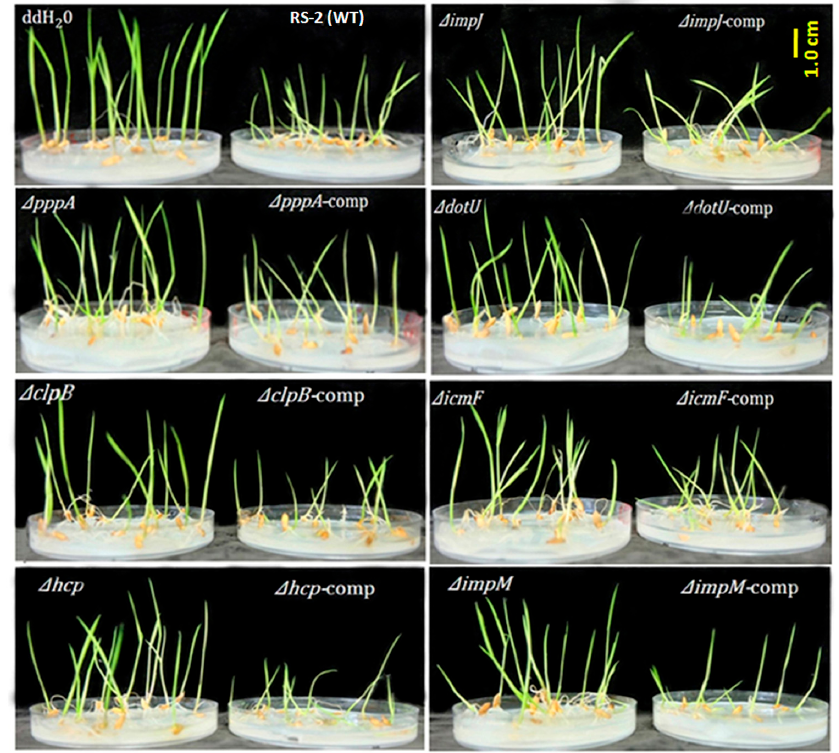
Figure 4. Seed-transmission assay for the virulence of the wild-type, the T6SS mutants and their corresponding complemented strains of Acidovorax avenae subsp. avenae strain RS-2 to rice seedling. Germinated rice seeds (cv. II You 023, n = 100/mutant) were inoculated with bacterial suspension of ~1×10 8 colony forming units (CFU)/mL. Fifteen seeds were planted per sterile agar (0.5%) plate and seedlings were evaluated 5 days after planting on plate.